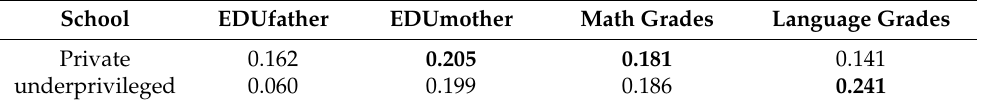
Table 4. Correlation coefficients between height SDS and the educational variables according to private and underprivileged school in Kupang (West-Timor). r < 0.05 are indicated by bold numbers. School Math Grades Language Grades